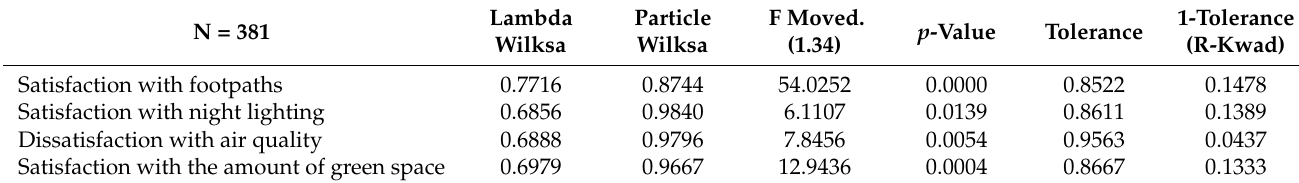
Table 7. Results of the discriminant